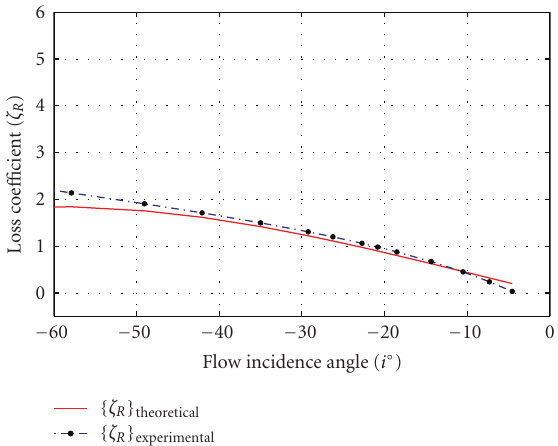
Figure 10: Rotor loss coe ffi cient versus incidence angle [10].